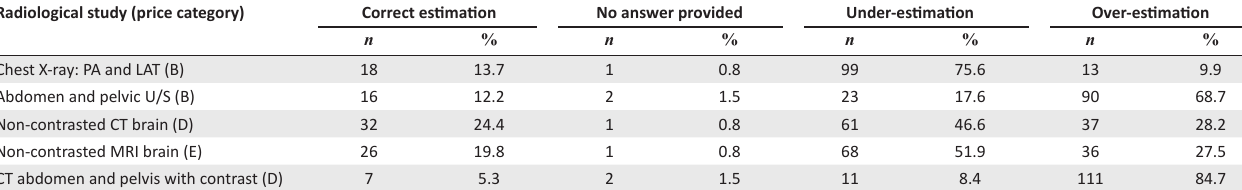
TABLE 4: Accuracy of cost estimation of radiological studies by participating doctors ( n = 131). Radiological study (price category)